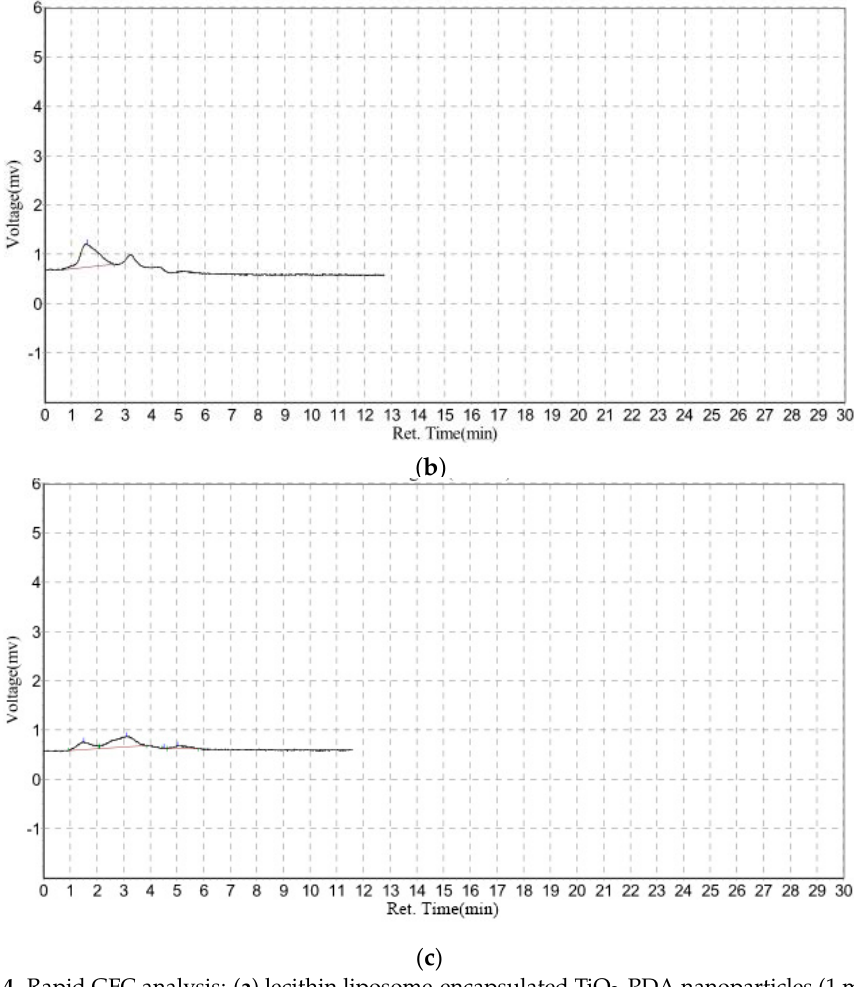
Figure 4. Rapid GFC analysis: ( a ) lecithin liposome-encapsulated TiO 2 -PDA nanoparticles (1 mg/mL); ( b ) lecithin liposome-encapsulated PDA nanoparticles; and ( c ) PDA nanoparticles, using λ ex = 365 nm and λ em = 460 nm for FD.